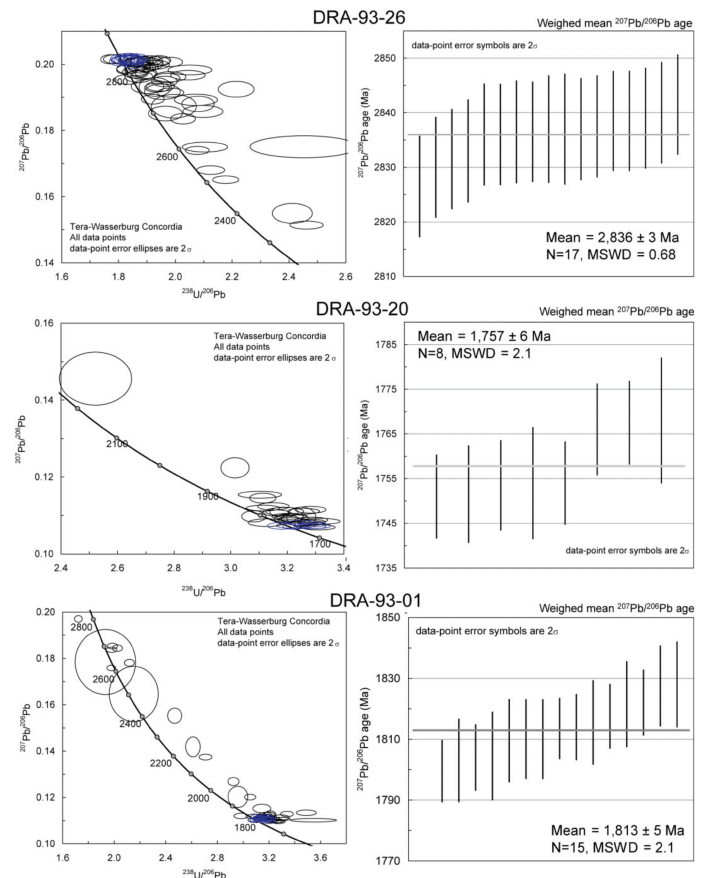
Figure 5. Unfiltered concordia plots of 207 Pb / 206 Pb versus 238 U / 206 Pb and corresponding ages showing the spread of zircon ages for samples analyzed in this study, and error-weighed mean 207 Pb / 206 Pb ages for DRA-93-26, DRA-93-20, and DRA-93-01 samples. The analyses used for the error-weighted mean calculations are highlighted in blue. Plots, ages, and age statistics are from Isoplot 3.7. See text for full